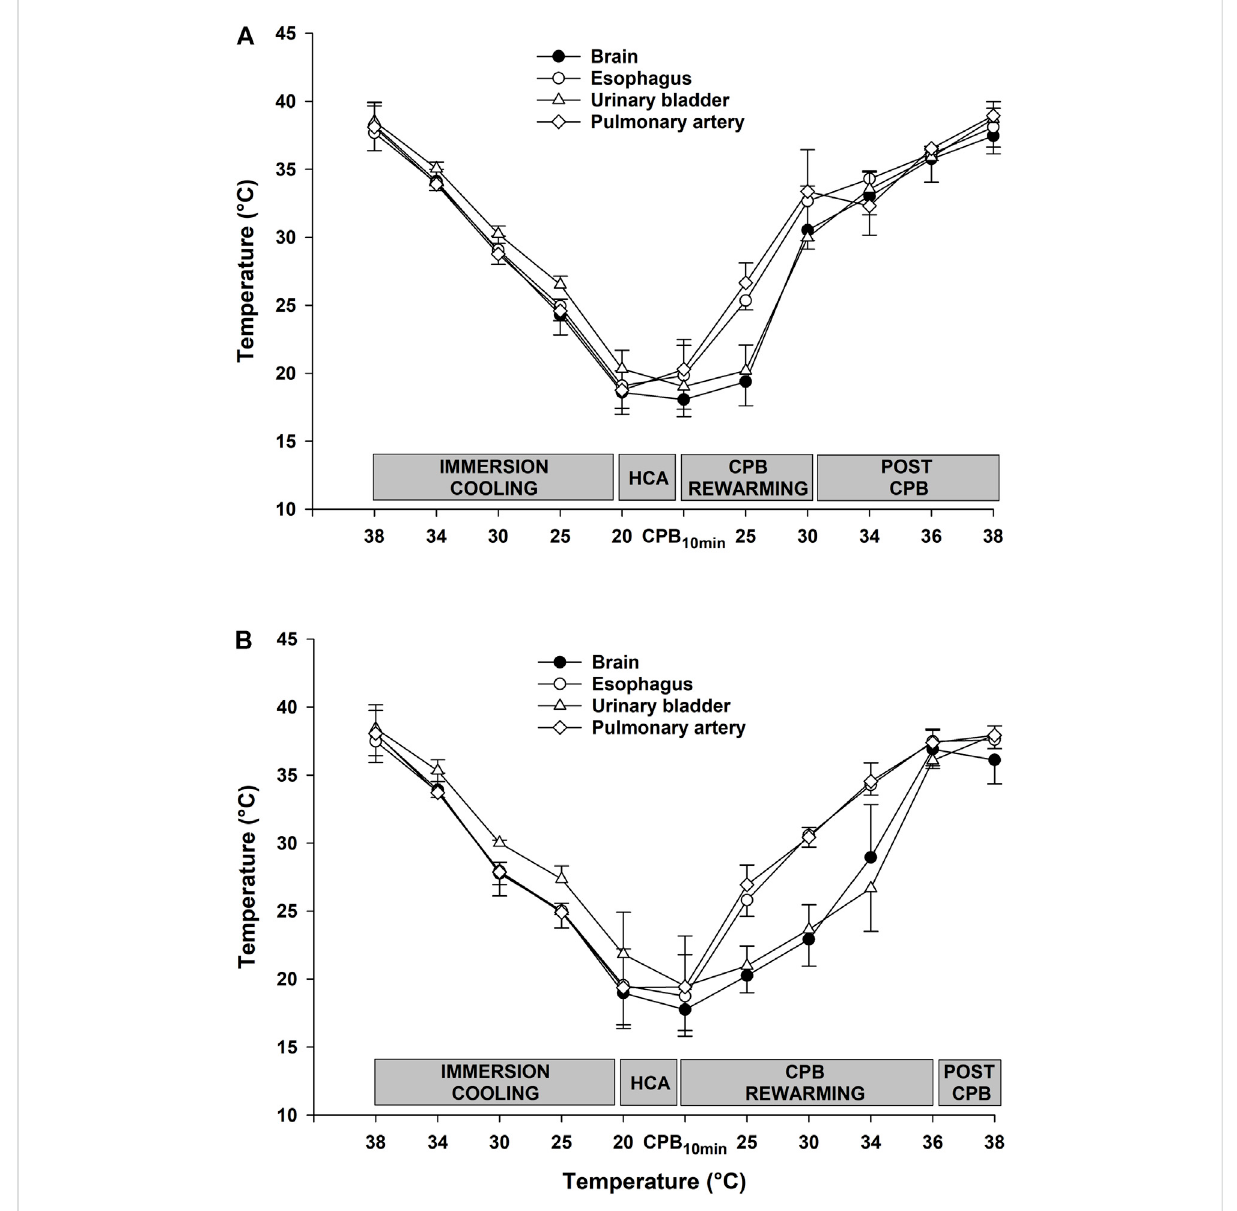
FIGURE 2 Temperatures at various body locations. (A) : CPB to 30 ° C and (B) : CPB to 36 °